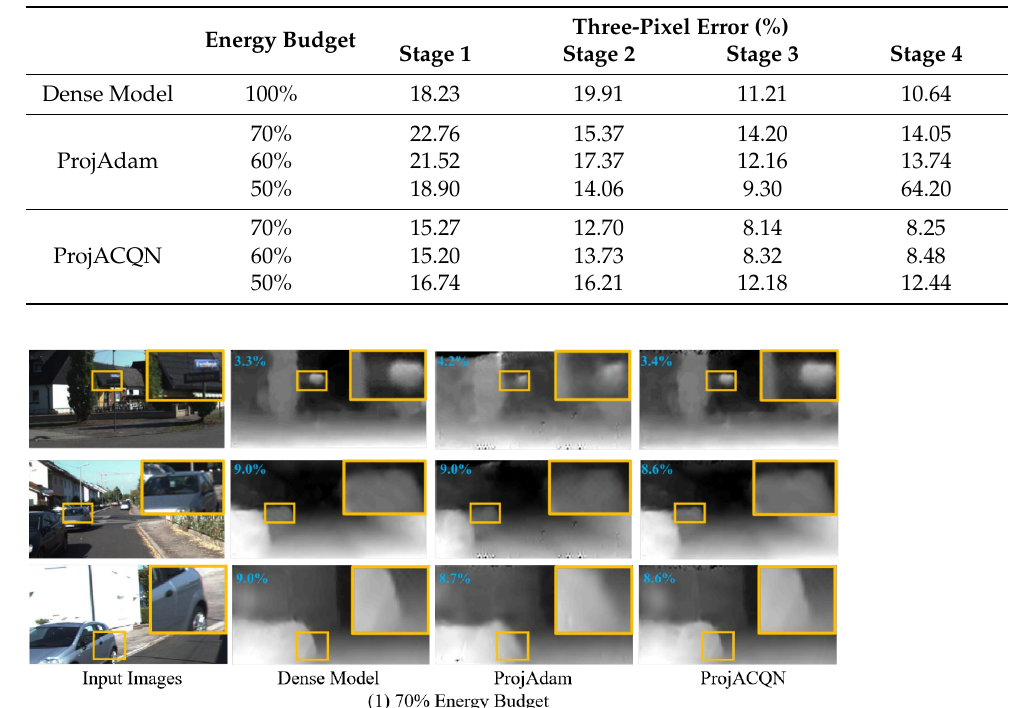
Table 4. Three-pixel error (%) of AnyNet with 50%, 60% and 70% energy budget on KITTI-2012 dataset using AGV. A lower three-pixel error is better.